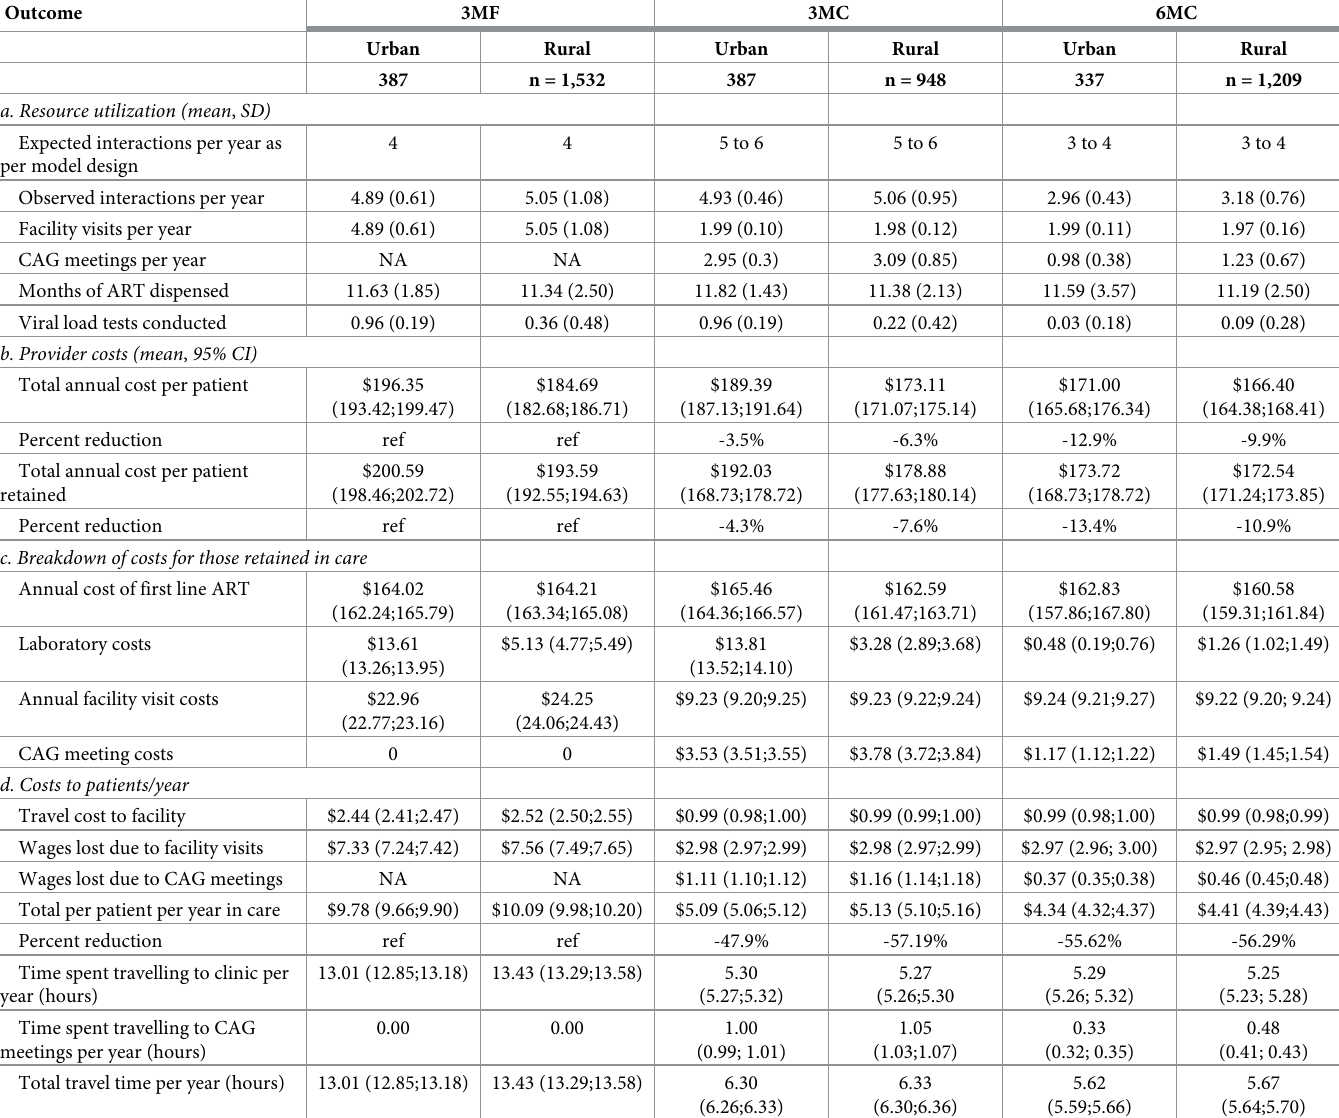
Table 2. Average resource utilization, cost per patient per year and per patient retained, and cost to patients by setting.